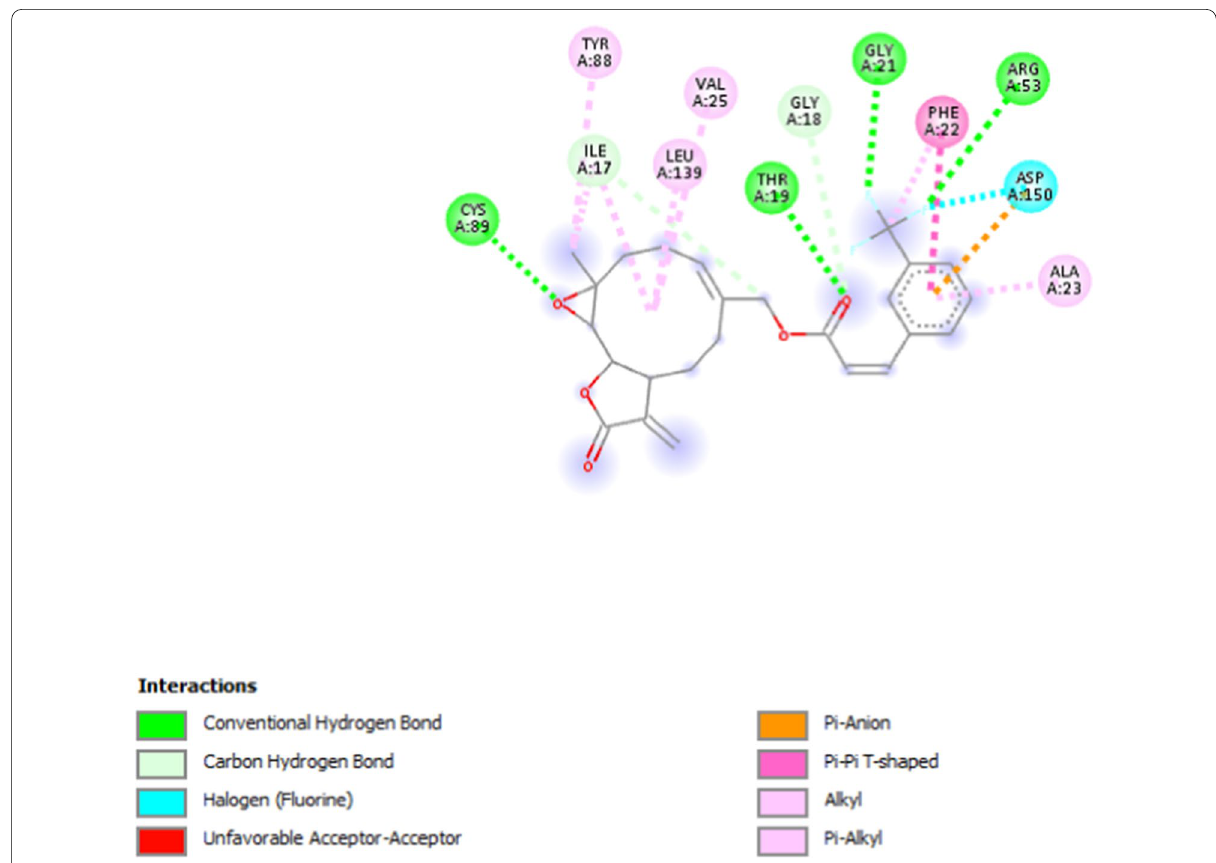
Fig. 6. 2D representation of complex